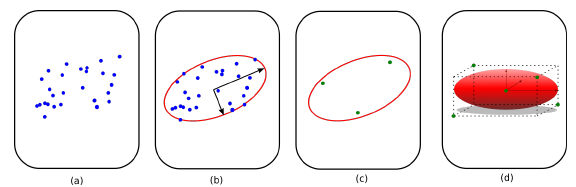
Figure 2. A toy example of structure approximation in 2D and 3D, where (a) shows the initial 2D structure, (b) shows the fitted ellipse, (c) the fictitious 2D structure, and (d) is the equivalent in 3D.